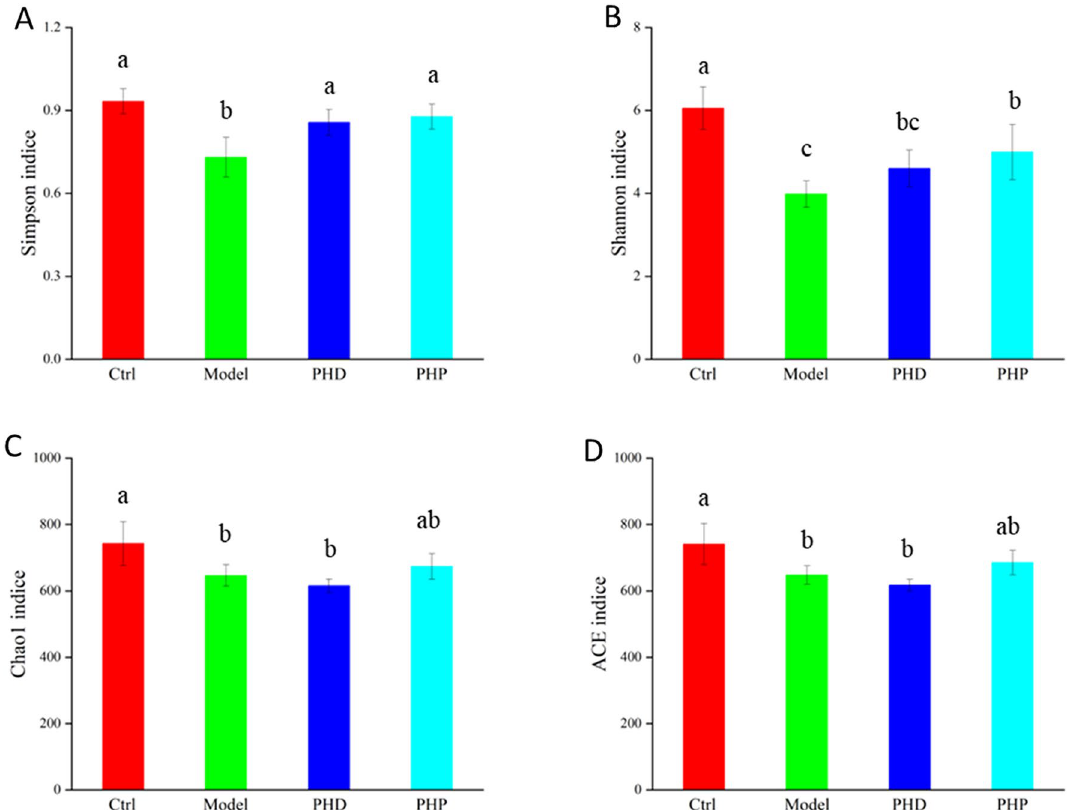
Figure 5. Effect of PHD and PHP on the α-diversity index (Simpson, Shannon, ACE and Chao1) of gut microbiota ( A – D ). Values was presented as mean ± SD (n = 5). Significant differences ( p < 0.05 ) were determined by one-way ANOVA and independent samples Kruskal–Wallis test using SPSS (version 33.0) software. Different lowercase letters (a, b and c) were significantly different at the level of p <